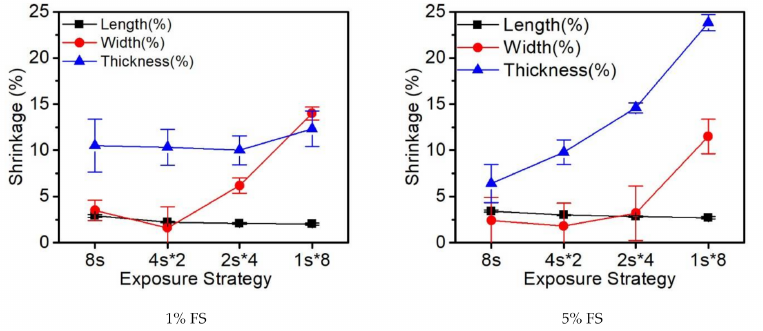
Figure 9. The shrinkage of tensile bar with different amounts of FS.